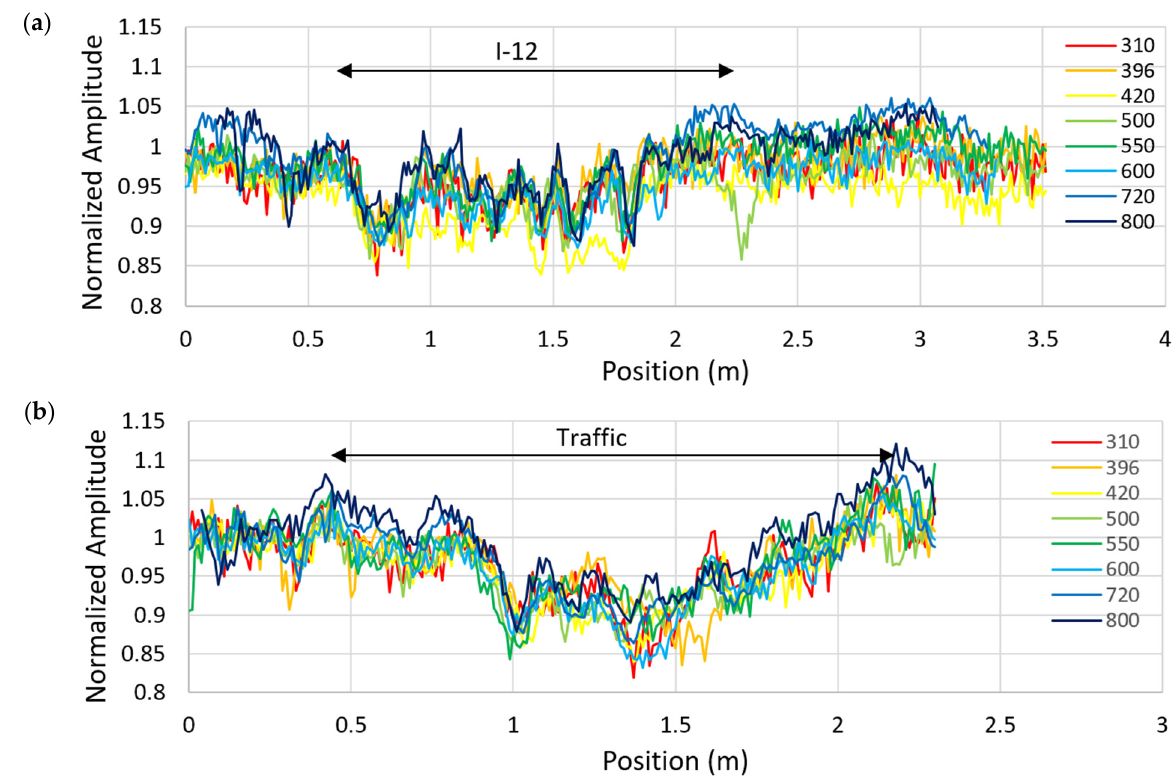
Figure A8. 1.5 GHz Norm. DW amplitudes on sand (I-11) in the ( a ) long. and ( b ) transv. direction vs. K loadings.